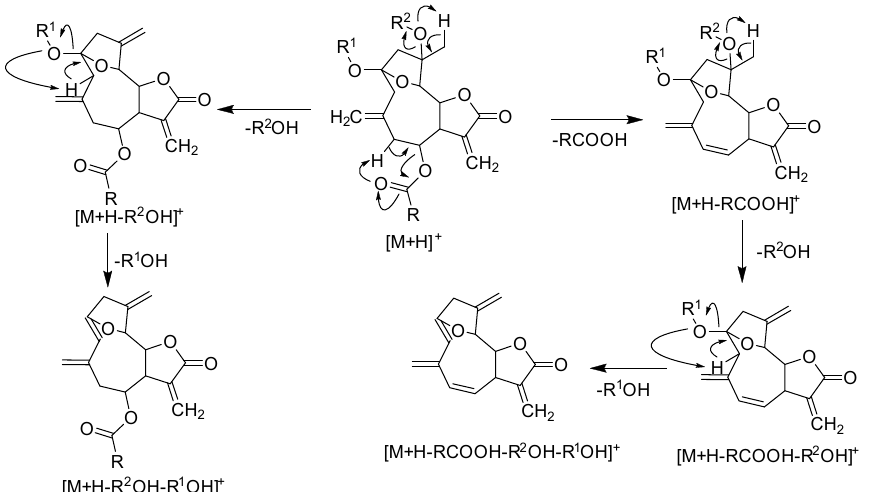
Figure 3. Proposed fragmentation patterns in hirsutinolide-like lactones under ESI conditions. 109